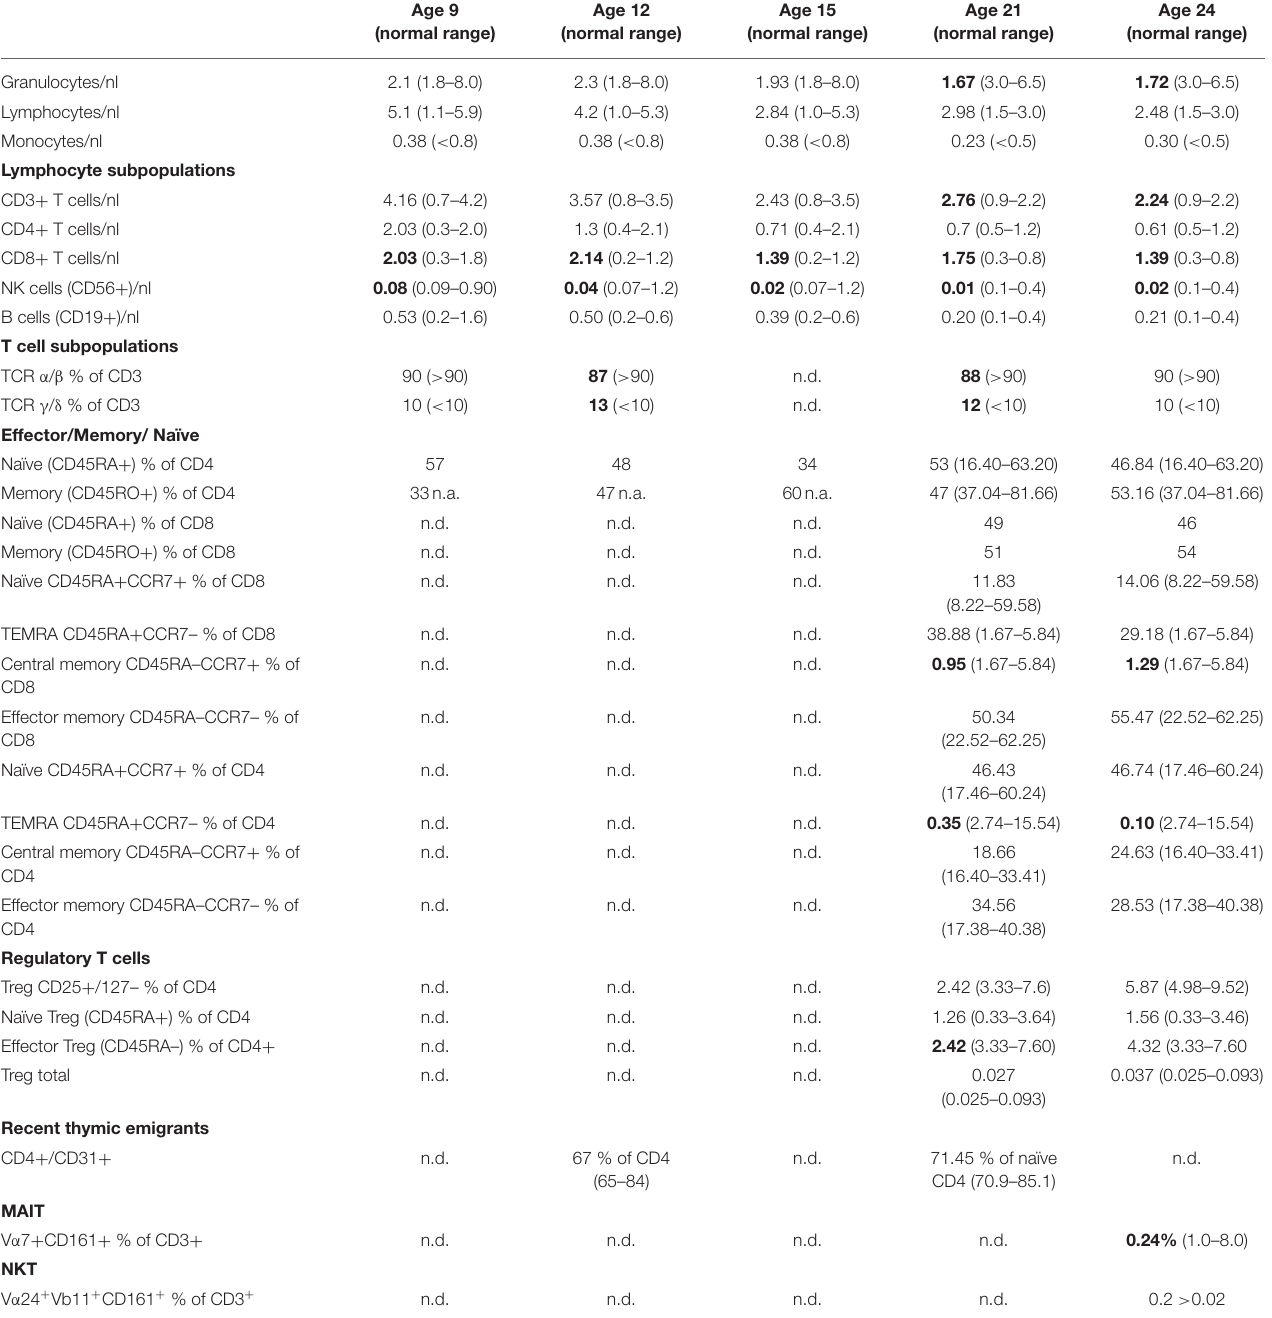
TABLE 1B | Lymphocyte subsets and T cell subsets at the age of 9, 12, 15, 21, and 24 years of